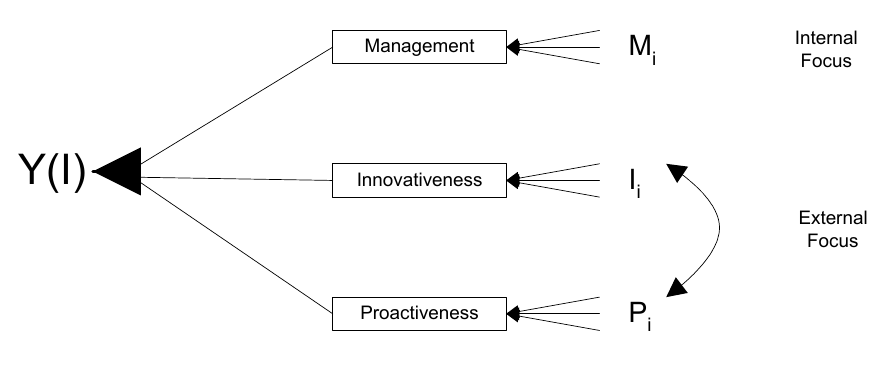
Figure 2: The final intrapreneurship